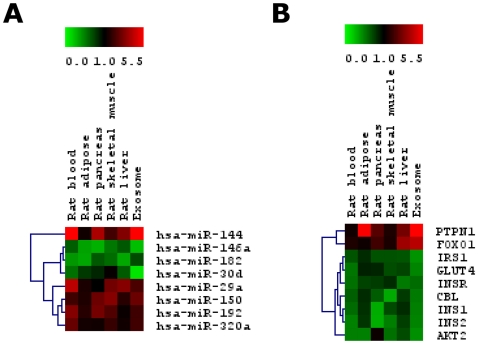
Comparison of miRNA expressions with its corresponding predicted mRNA targets (in rat's blood, tissues and exosomes).
A
. A heatmap of quantitative stem-loop RT-PCR and real-time PCR of selected miRNAs and mRNAs respectively. Samples are obtained from a combination of low dose STZ and high-fat diet induced T2D rat model. B
. A heatmap of quantitative stem-loop RT-PCR and real-time PCR of selected miRNAs and mRNAs respectively. Samples are obtained from high-fat diet induced T2D rat model. Validation has been done in triplicates. Statistically significant differences are tested at p<0.05 significance. Green: down-regulation; Red: up-regulation; Grey: not detected. Predictions: miR-144/IRS1; miR-146a/PTPN1; miR-150/GLUT4 and CBL; miR-182/FOXO1; miR-192/INSR; miR-30d/INS; miR-29a and miR-320/AKT2.